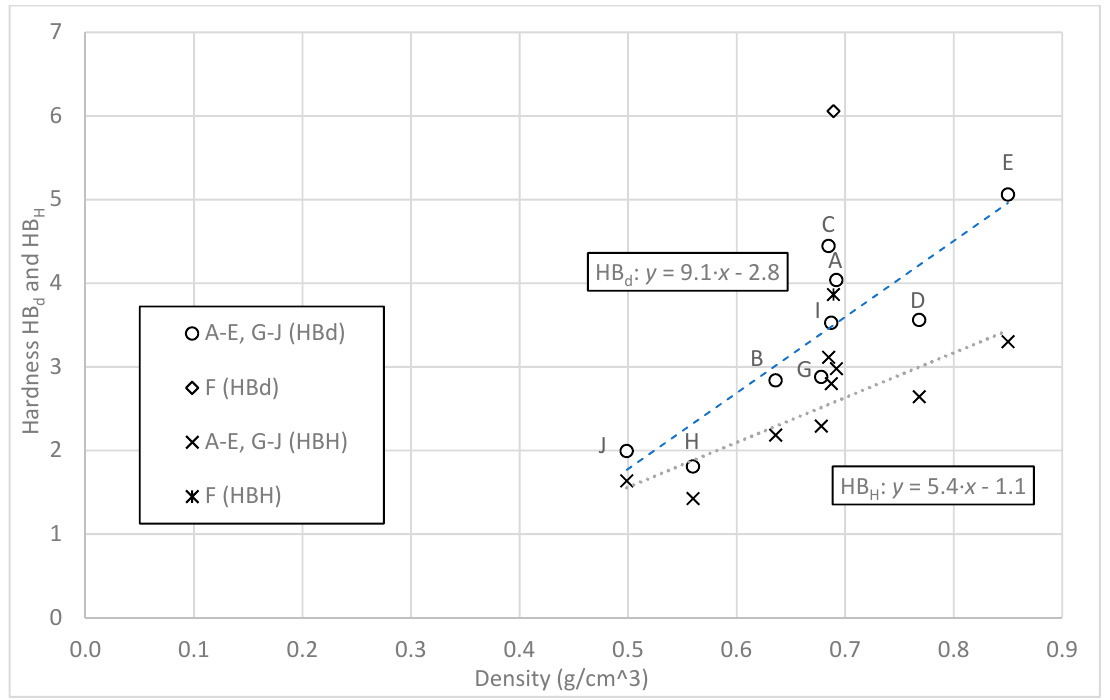
Figure 8. Hardness of HB d and HB H depending on sample density.